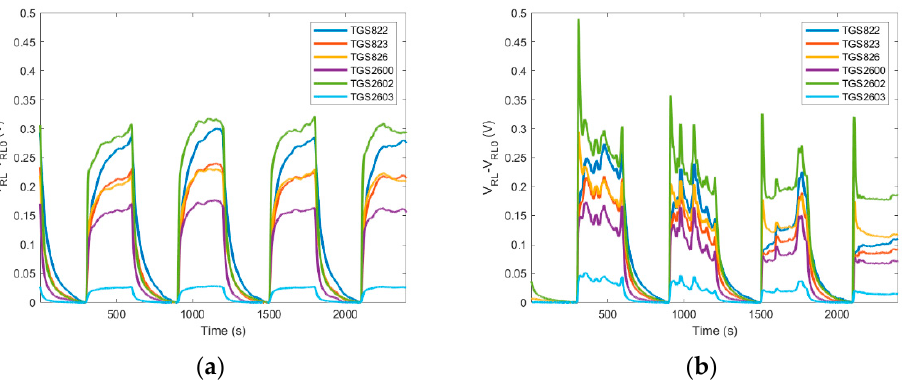
Figure 9. Gas sensor responses to beehive air when the probe was located: ( a ) between combs, ( b ) near the beehive exit.